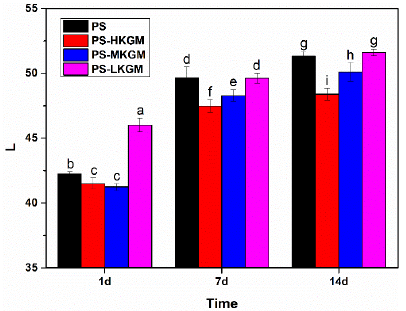
Figure 1. L values of PS — KGM mixtures at different storage times (HKGM, MKGM and LKGM represent KGM with high, medium and low molecular weight, respectively. PS represents pea starch. Different letters indicate significant differences at the p < 0.05 level).